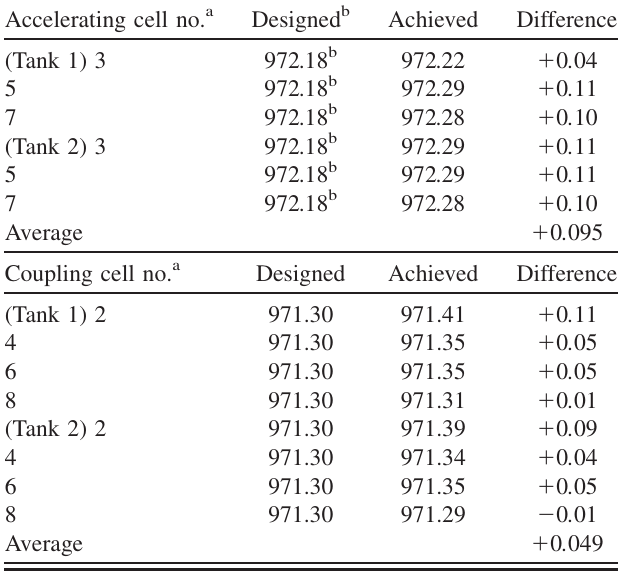
TABLE V. Normal cell frequencies after the final machining vs the designed frequency (unit: MHz).